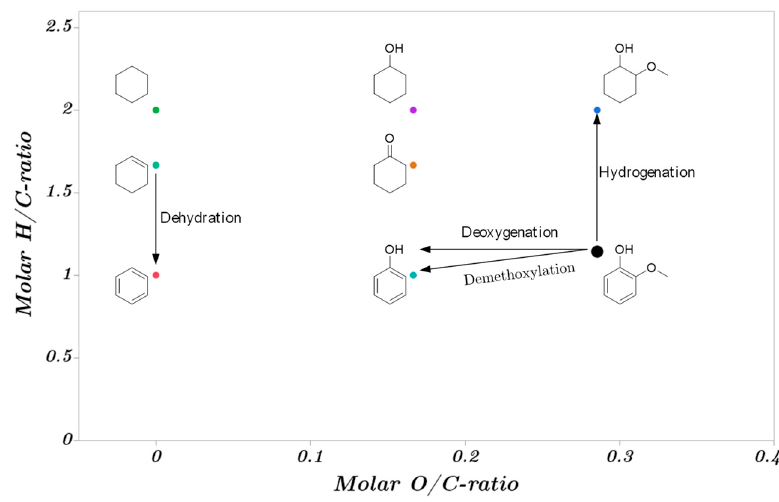
Figure 12. Pseudo van Krevelen diagram of the conversion of guaiacol (black dot) to various products observed during the hydrodeoxygenation of guaiacol (colored dots).